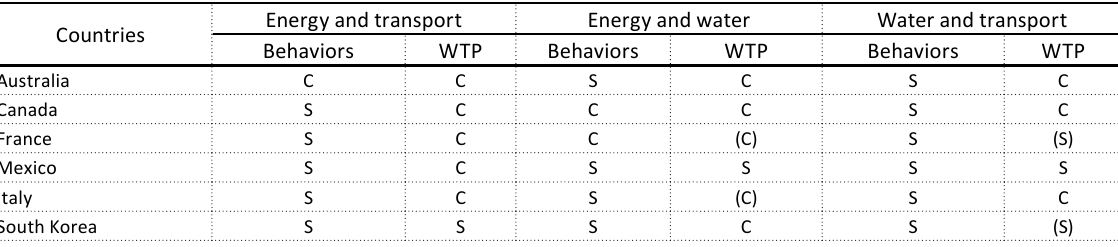
Table 5. Summary of